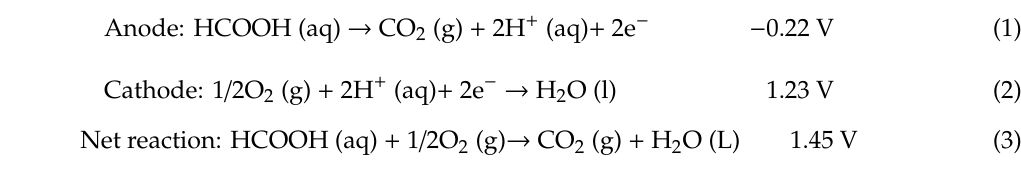
Table 2. Theoretical reaction potential and measured open circuit potentials of the studied cells.